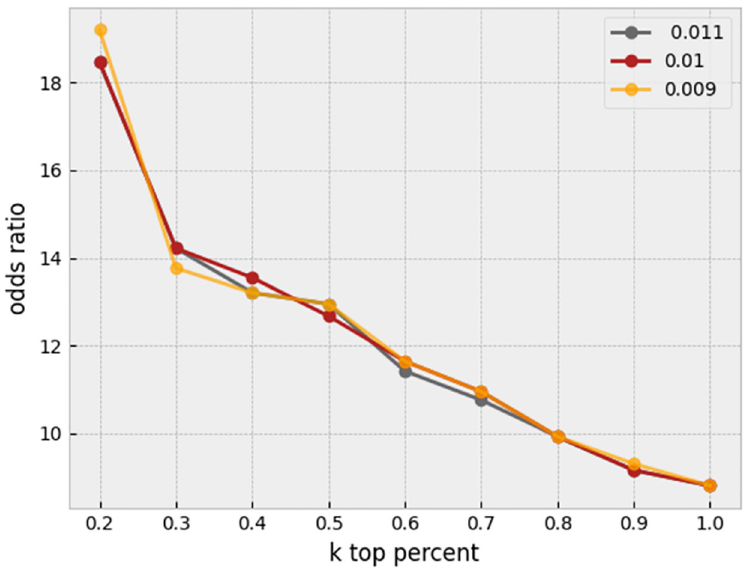
Fig 10. Sensitivity analysis. The proportion of outliers in each plate is set to different amounts of 0.009, 0.01, and 0.011 after applying preprocessing and before regressing